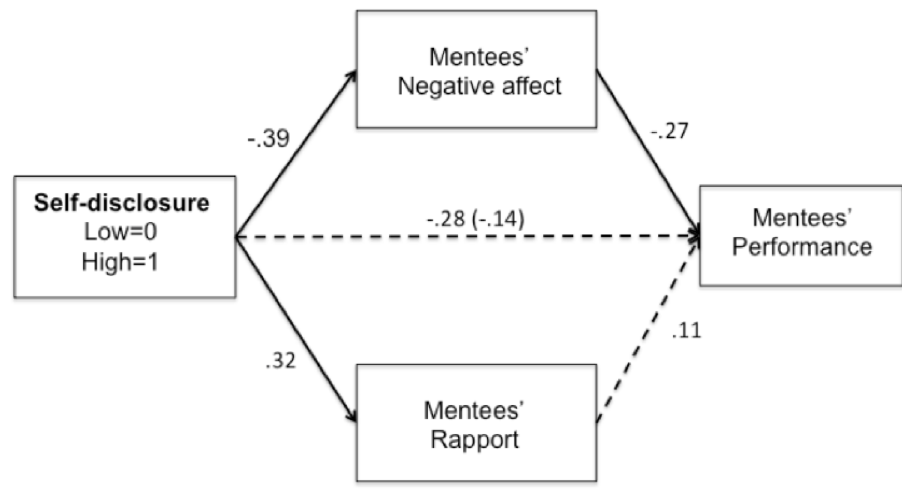
Fig 1. Path model predicting performance. Solid lines indicate significant paths. Dashed lines indicate non- significant paths. Coefficients are unstandardized. Parenthetical number indicates total effect